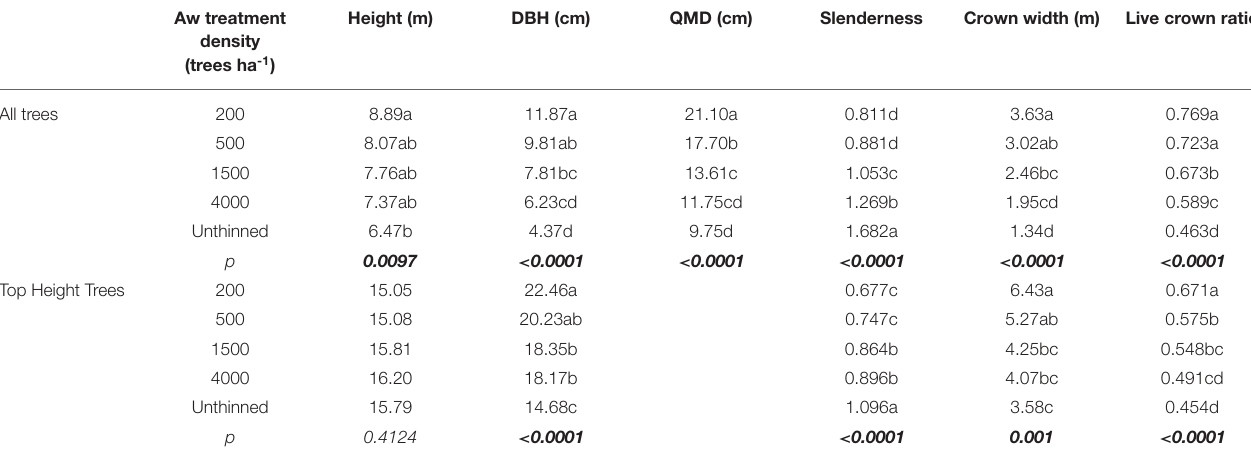
TABLE 2 | Treatment effects on aspen at age 26.